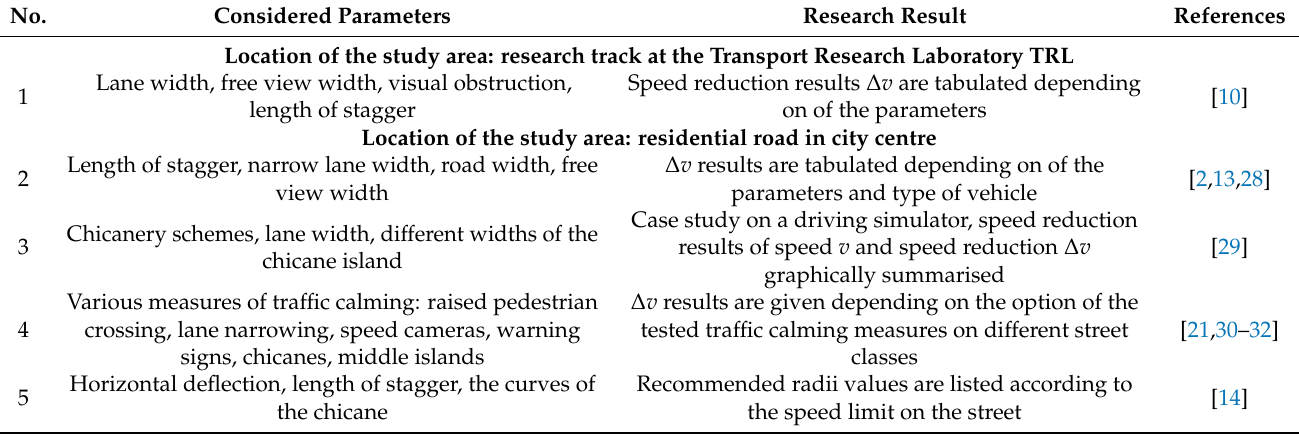
Table 2. Considered parameters, area locations and results of previous research (supplemented based on [26,27]).